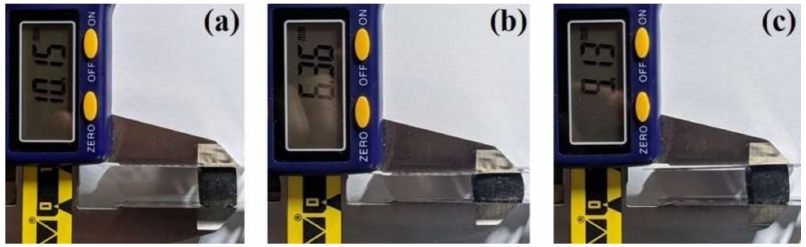
Figure 17. Demonstration of the resilience properties of an equilibrium swollen sample of Co-filled pHEMA-gr-PVP copolymer: ( a ) initial sample; ( b ) sample under load; ( c ) sample after